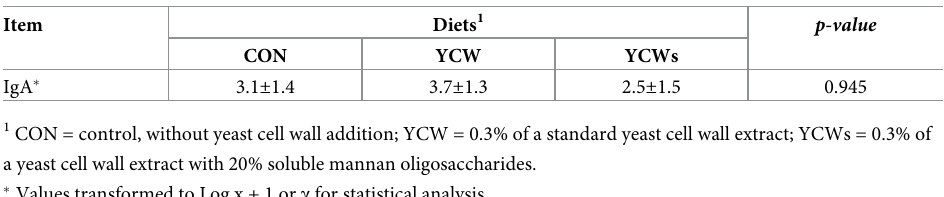
Values transformed to Log x + 1 or γ for statistical analysis.